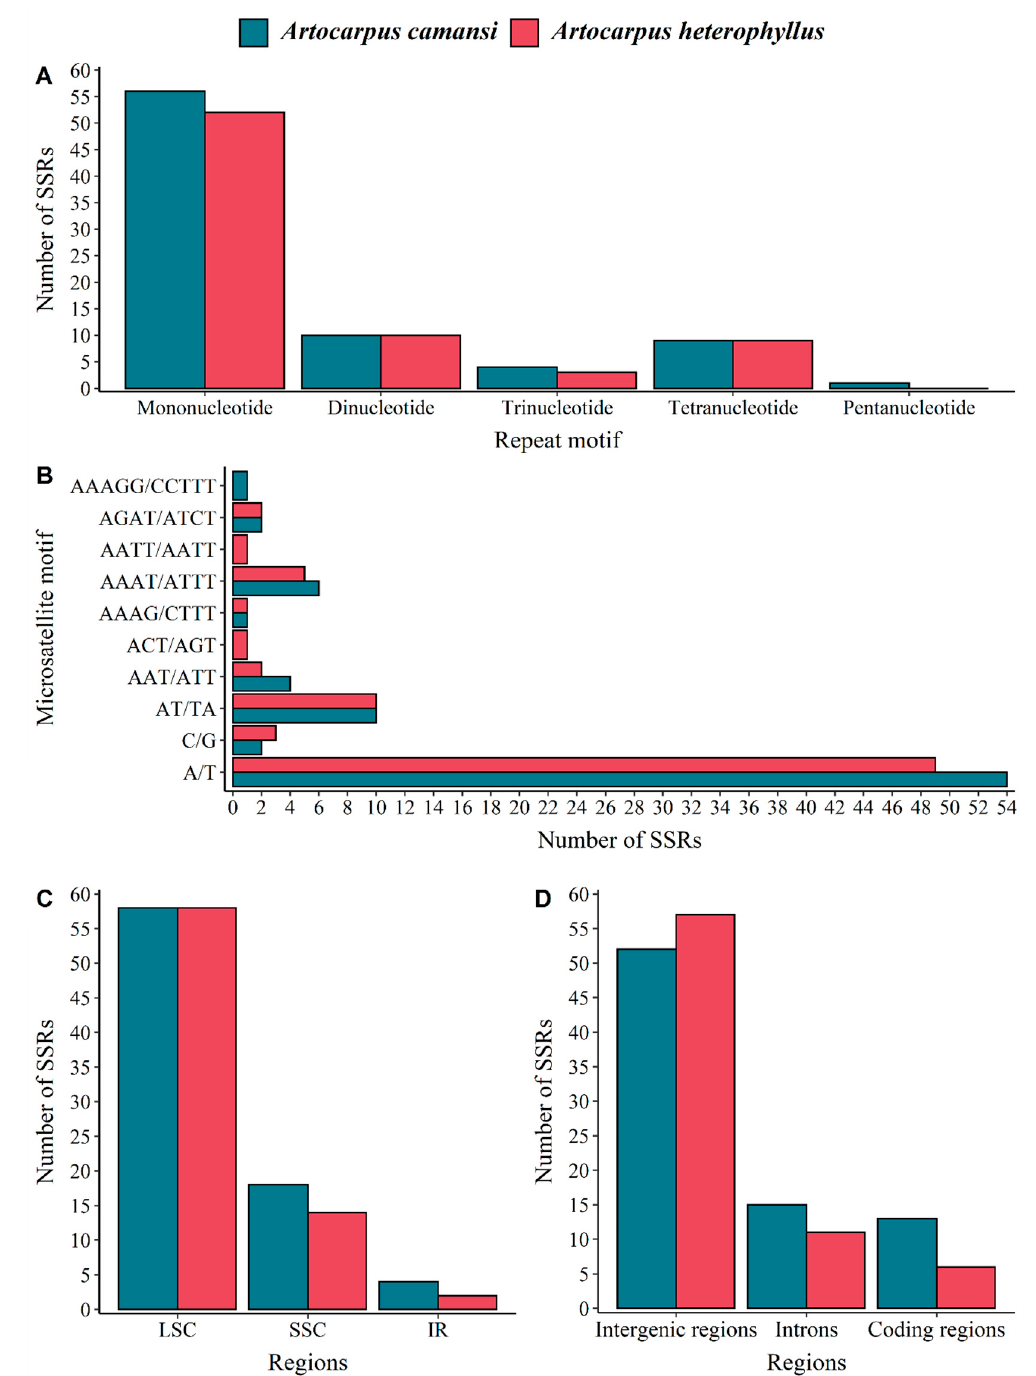
Figure 2. Distribution of the microsatellites identified in the A. camansi plastid genome. ( A ) The number of different microsatellite types detected; ( B ) The number of different microsatellite motifs detected; ( C ) The number of microsatellites in the different regions of the plastid genome; ( D ) The number of microsatellites in intergenic and coding regions, and the introns.